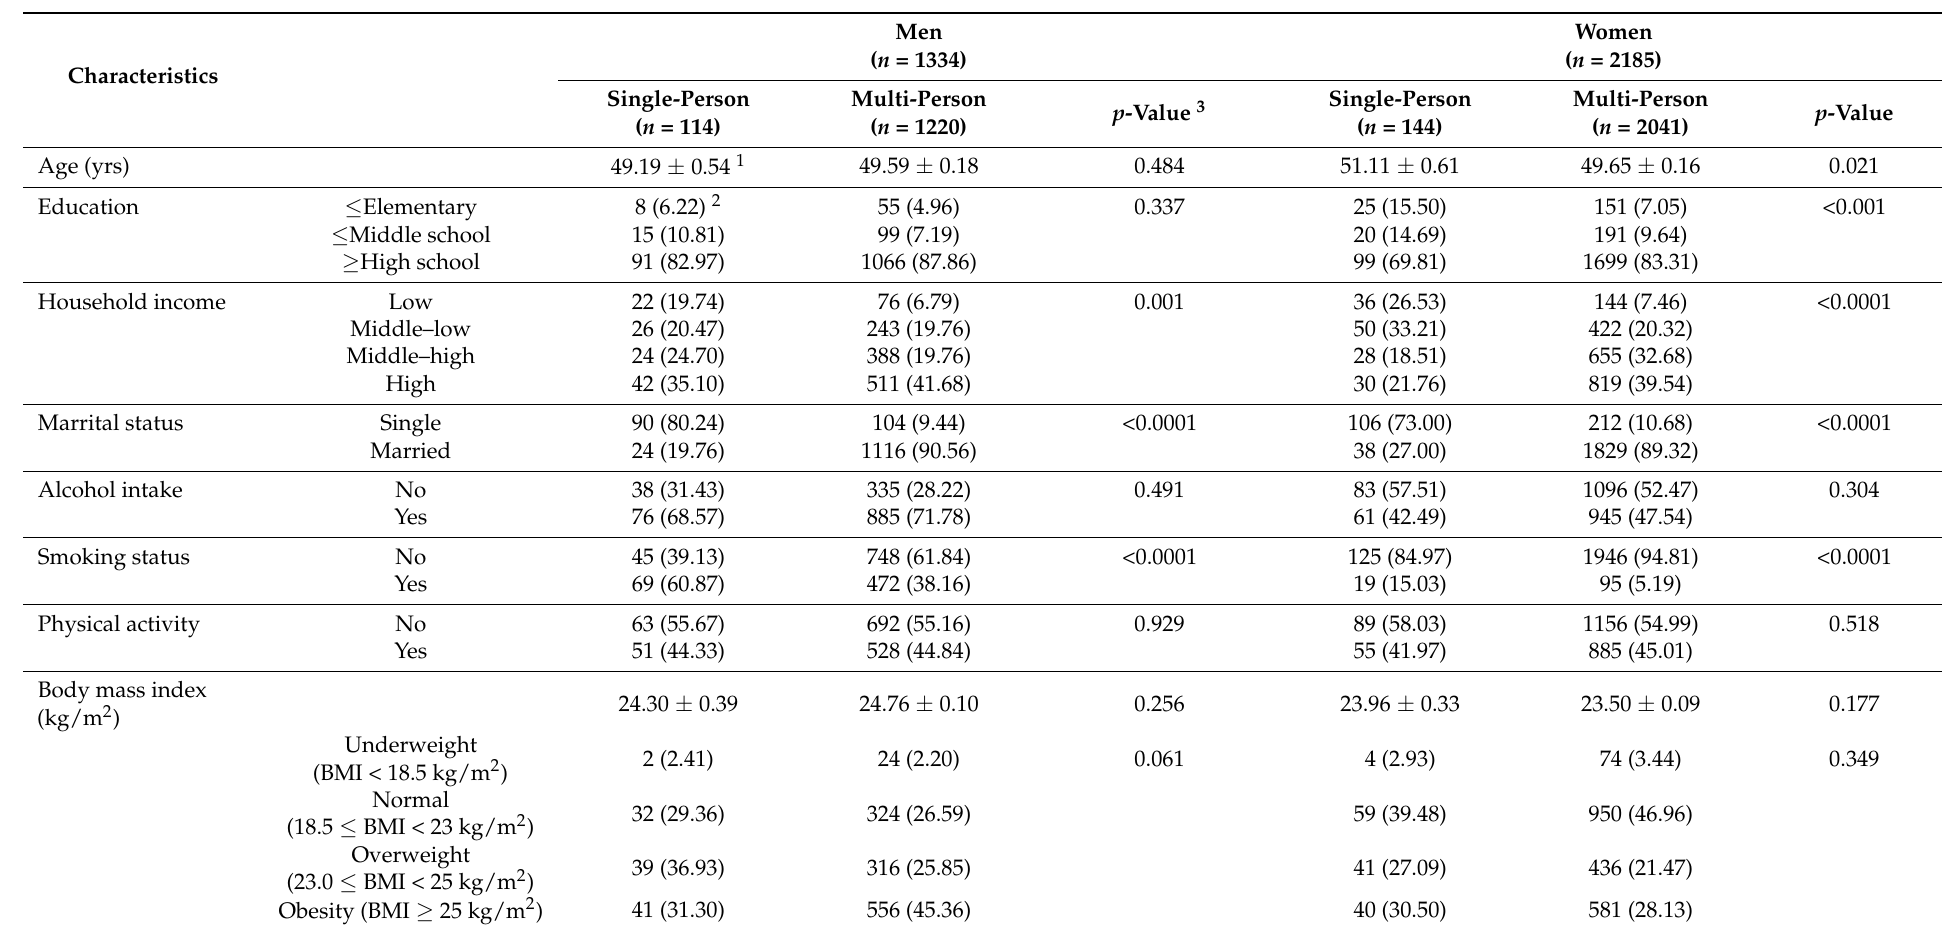
Table 1. Socio-demographic characteristics by participants according to household size by